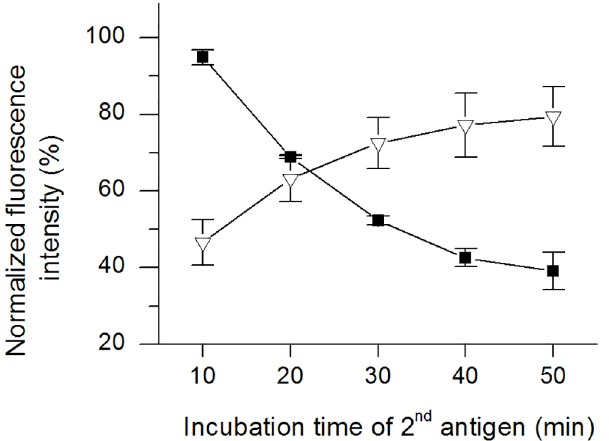
Fig 9. Dynamic range of time-dependent replacement in both directions. The assays were carried out three times. The mean intensity, resulting from assay repetition, was normalised to the positive control and shown as a percentage for the different time points. Black squares = GFP-hCC → hCC, white triangles = hCC → GFP-hCC.